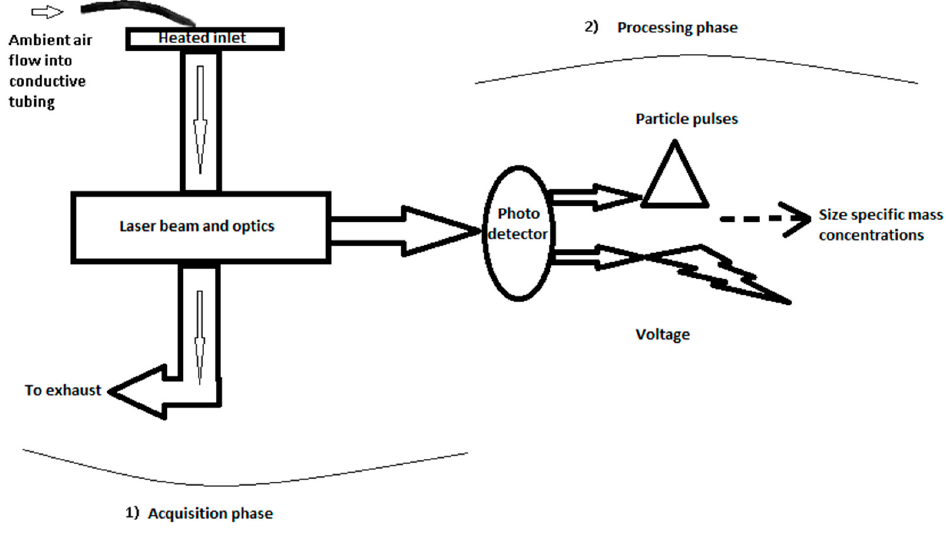
Figure 2. Simple schematic illustrating measurement principle for the NRM DustTrak DRX. There are two main phases, namely the 1) acquisition and 2) processing phases.